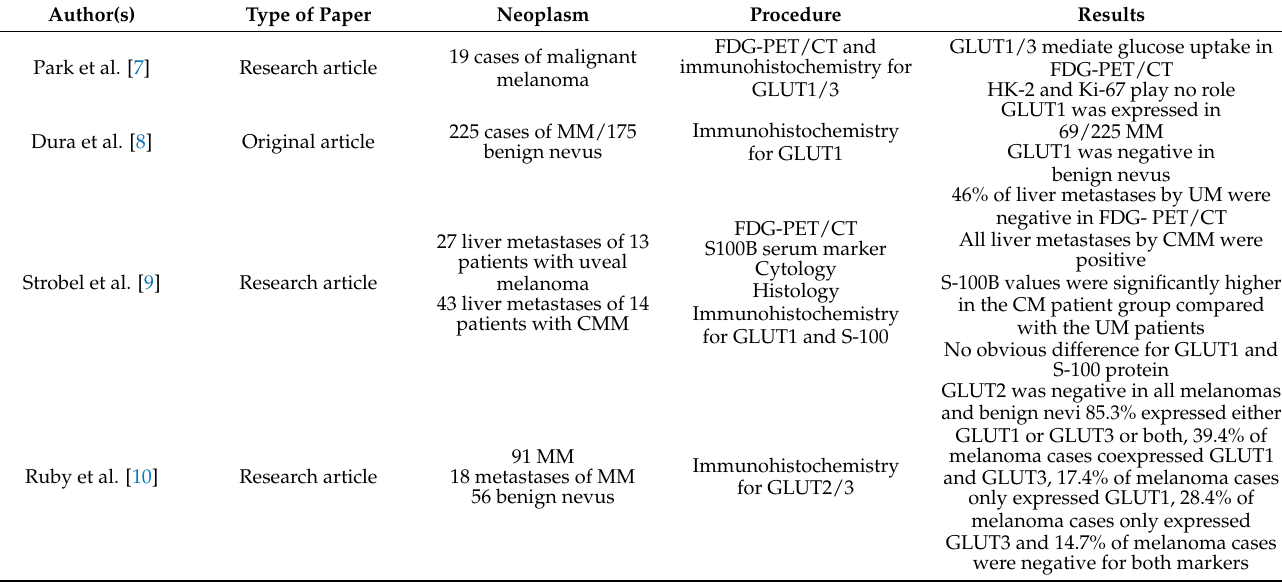
Figure 1. Research of the literature and selection of articles according to PRISMA guidelines. Table 1. Summary of the papers examined in this review.